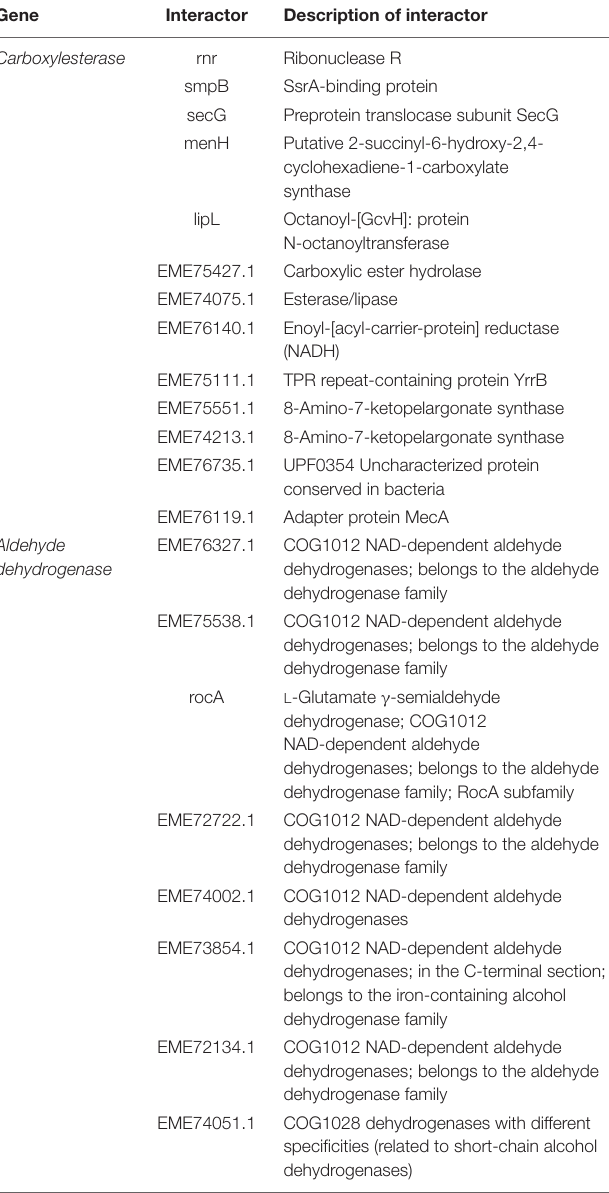
TABLE 1 | Network description of carboxylesterase and aldehyde dehydrogenase of marine Bacillus